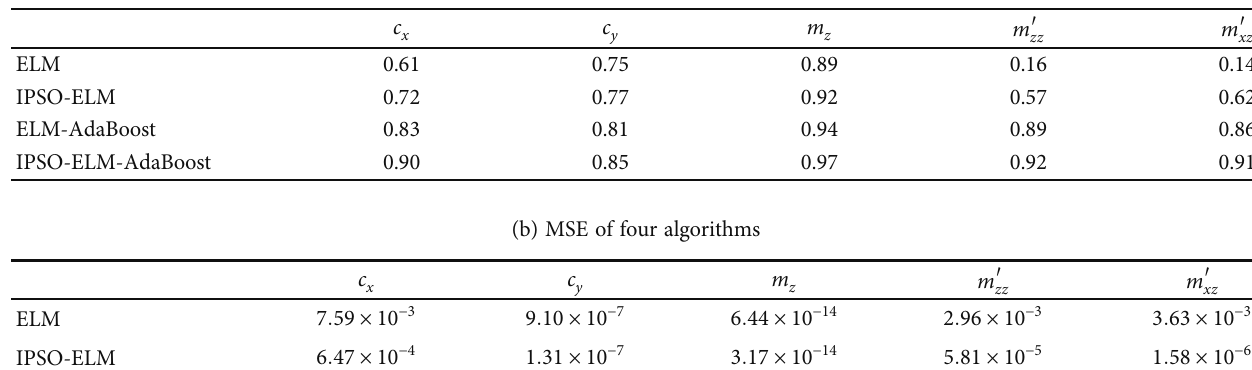
(a) R of four algorithms